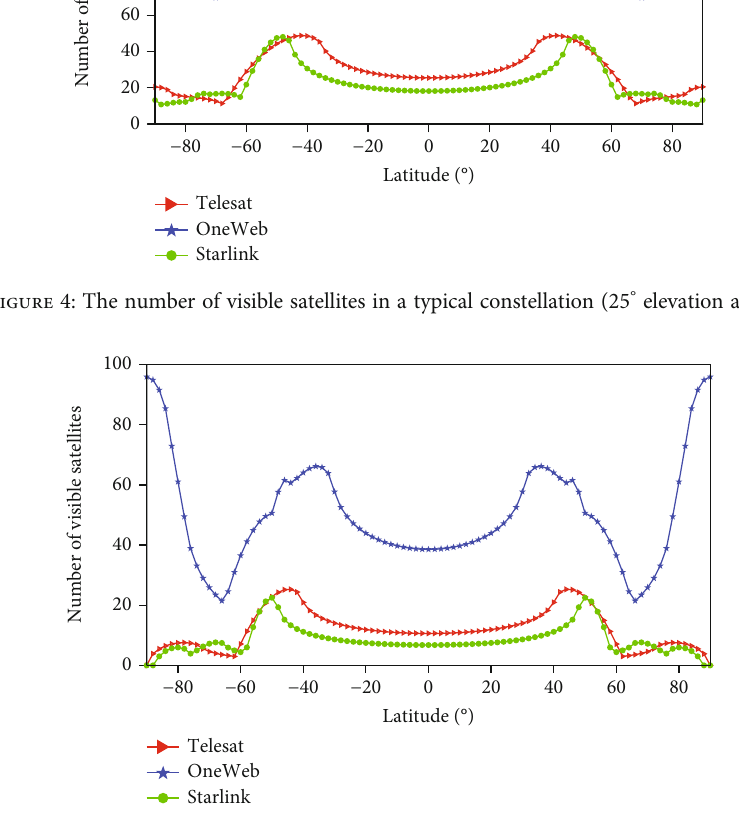
Figure 5: The number of visible satellites in a typical constellation (40 ° elevation angle). Table 2: Typical constellation con fi guration distribution